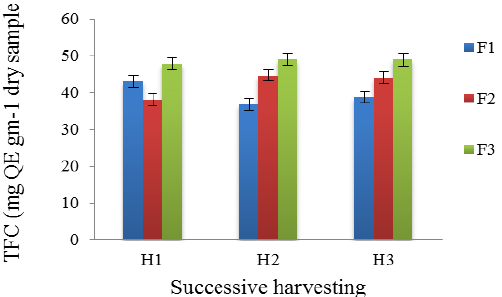
Fig. 4. Effect of fertilizer type (F) and successive harvesting (H) on total flavonoid content (TFC). Note: F1: NPK 15-15-15; F2: NPK 8-8-8; F3: NPK 5-5-5; H1: 1st harvest; H2: 2nd harvest; H3: 3rd harvest. Error bars represent standard error